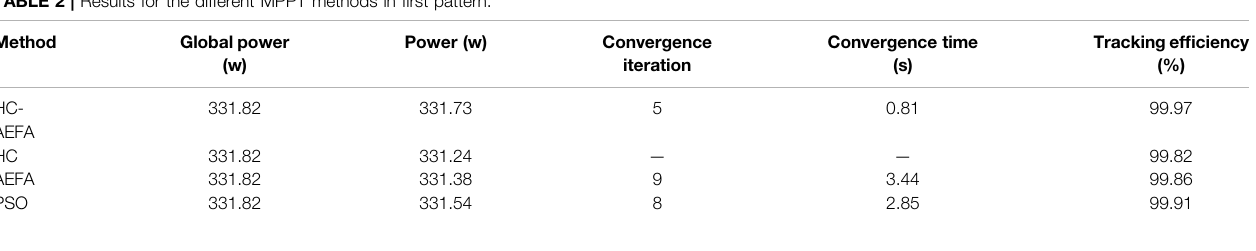
TABLE 2 | Results for the different MPPT methods in fi rst